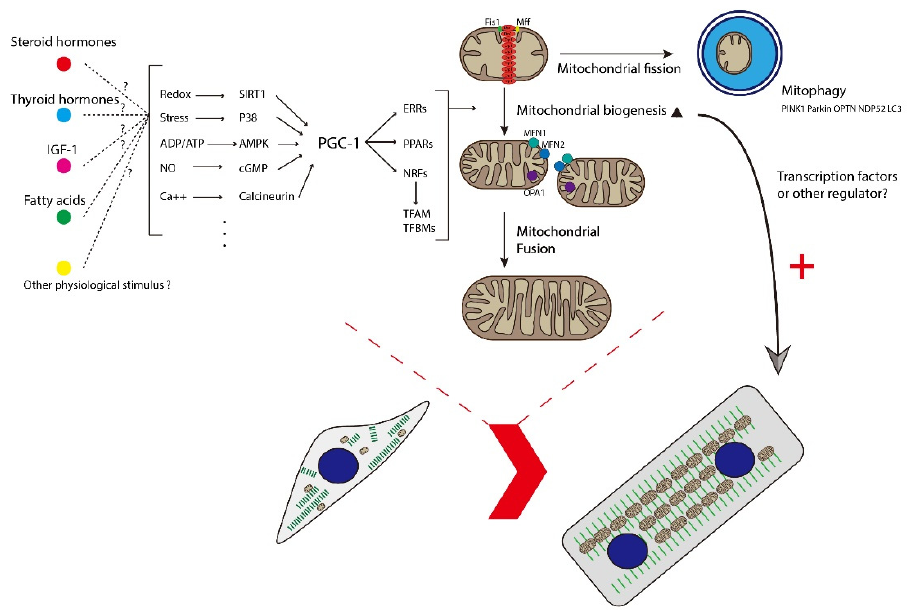
Figure 2. Schematic diagram showing how mitochondrial biogenesis, dynamics, and mitophagy participate in the maturation of CMs. Multiple stimuli activate PGC-1, leading to the coactivation of key transcription factors involved in several aspects of mitochondrial and cellular function. Mitochondria dynamically change their morphology through the cycle of fusion and fission. The main fusion factors are OPA1, MFN1, and MFN2, which bind to the IMM and OMM of mitochondria. Drp1 is a major fission factor that binds to OMM and forms a ring-like structure around mitochondria, leading to the separation of mitochondria into two. Mff and Fis1 function as adaptors to recruit Drp1 to the OMM. Mitochondrial fission and mitophagy function as quality control to segregate and degrade immature or damaged mitochondria and to provide materials for mitochondrial biogenesis. Healthy mitochondria tend to fuse together and are believed to function well. The maturation of healthy mitochondria further promotes the maturation of CMs at structural and functional levels. IGF-1, insulin-like growth factor 1; PGC-1, peroxisome proliferator-activated receptor γ coactivator 1; ERR, estrogen-related receptor; PPARs, peroxisome proliferator-activated receptors; NRF, nuclear respiratory factor; TFAM, transcription factor A, mitochondrial; TFBMs, mitochondrial transcription factor B; Fis1, fission protein-1; Mff, mitochondrial fission factor; OPA1, optic atrophy 1; MFN1, mitofusin 1; MFN2, mitofusin 2; PINK1, PTEN-induced kinase 1; OPTN, optineurin; NDP52, calcium binding and coiled-coil domain 2; LC3, microtubule-associated protein 1A/1B-light chain